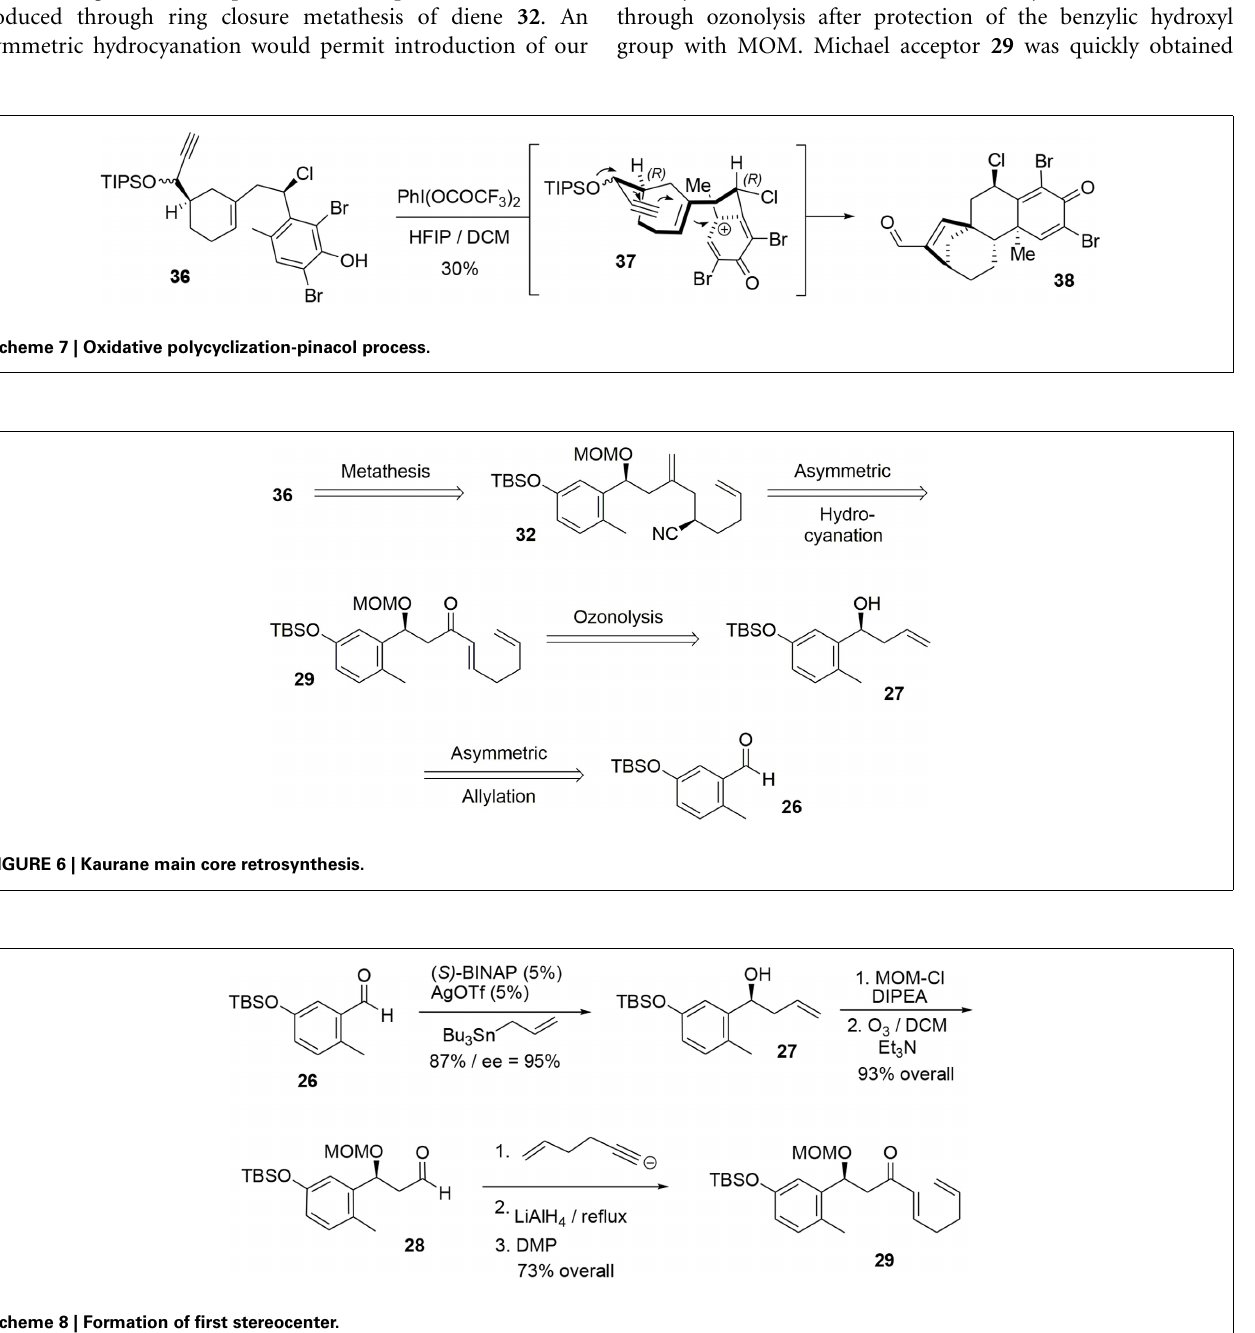
Scheme 8 | Formation of first